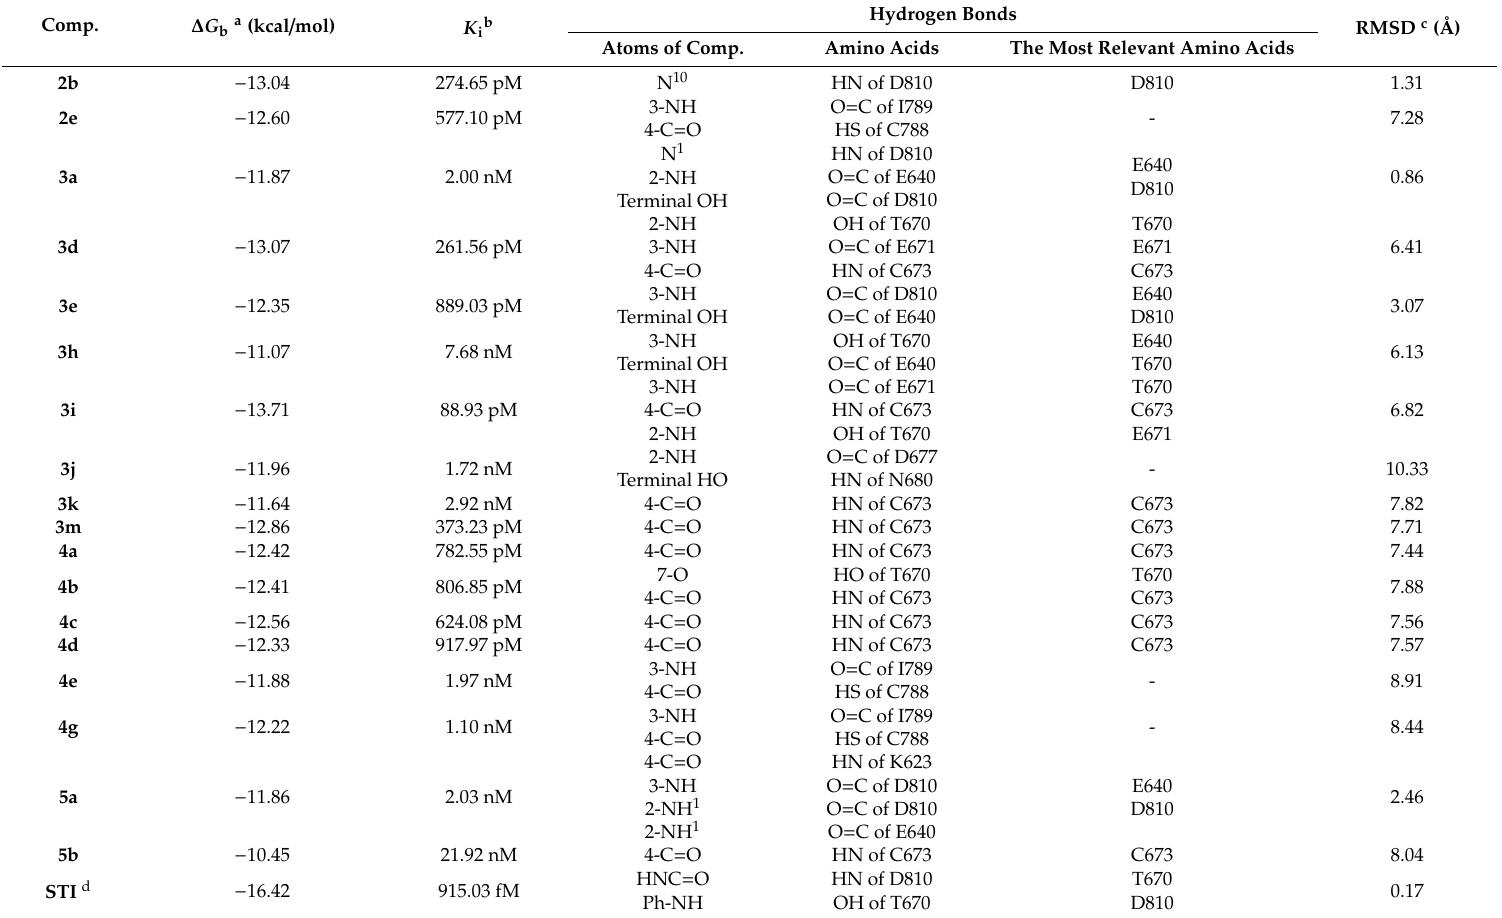
Table 3. The best compounds docked by flexible docking results (AutoDock 4.2), considering the binding free energies ( ∆ G b ) and inhibition constants ( K i ) of 5-deazalloxazine derivatives docked into c-kit PTK (1t46).